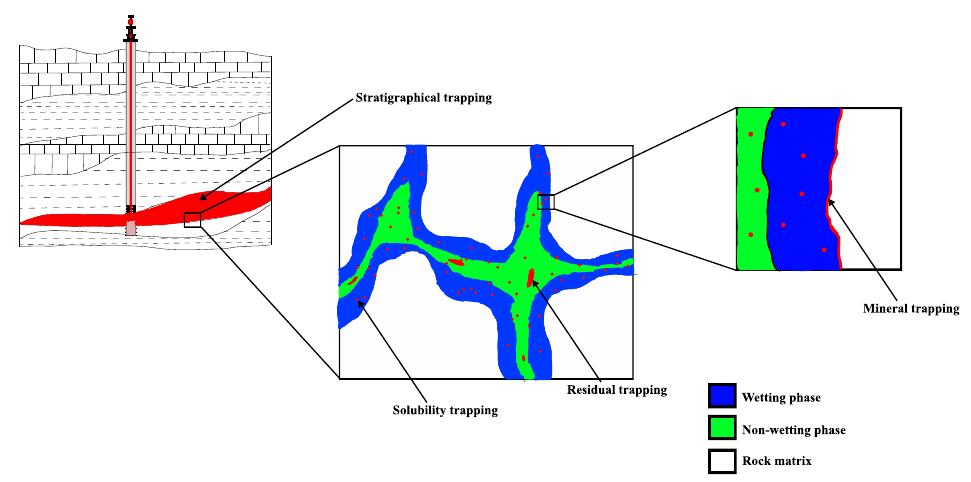
Figure 4. CO 2 storage mechanisms in a porous